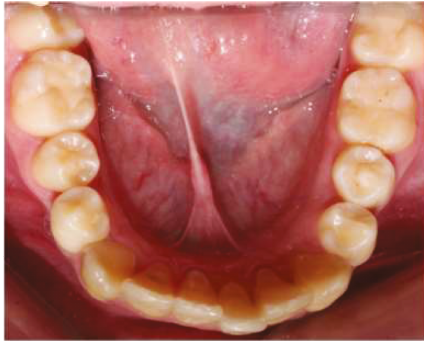
Figure 7: Intraoral photo postmarsupialization with the mandibular left second premolar completely erupted on the